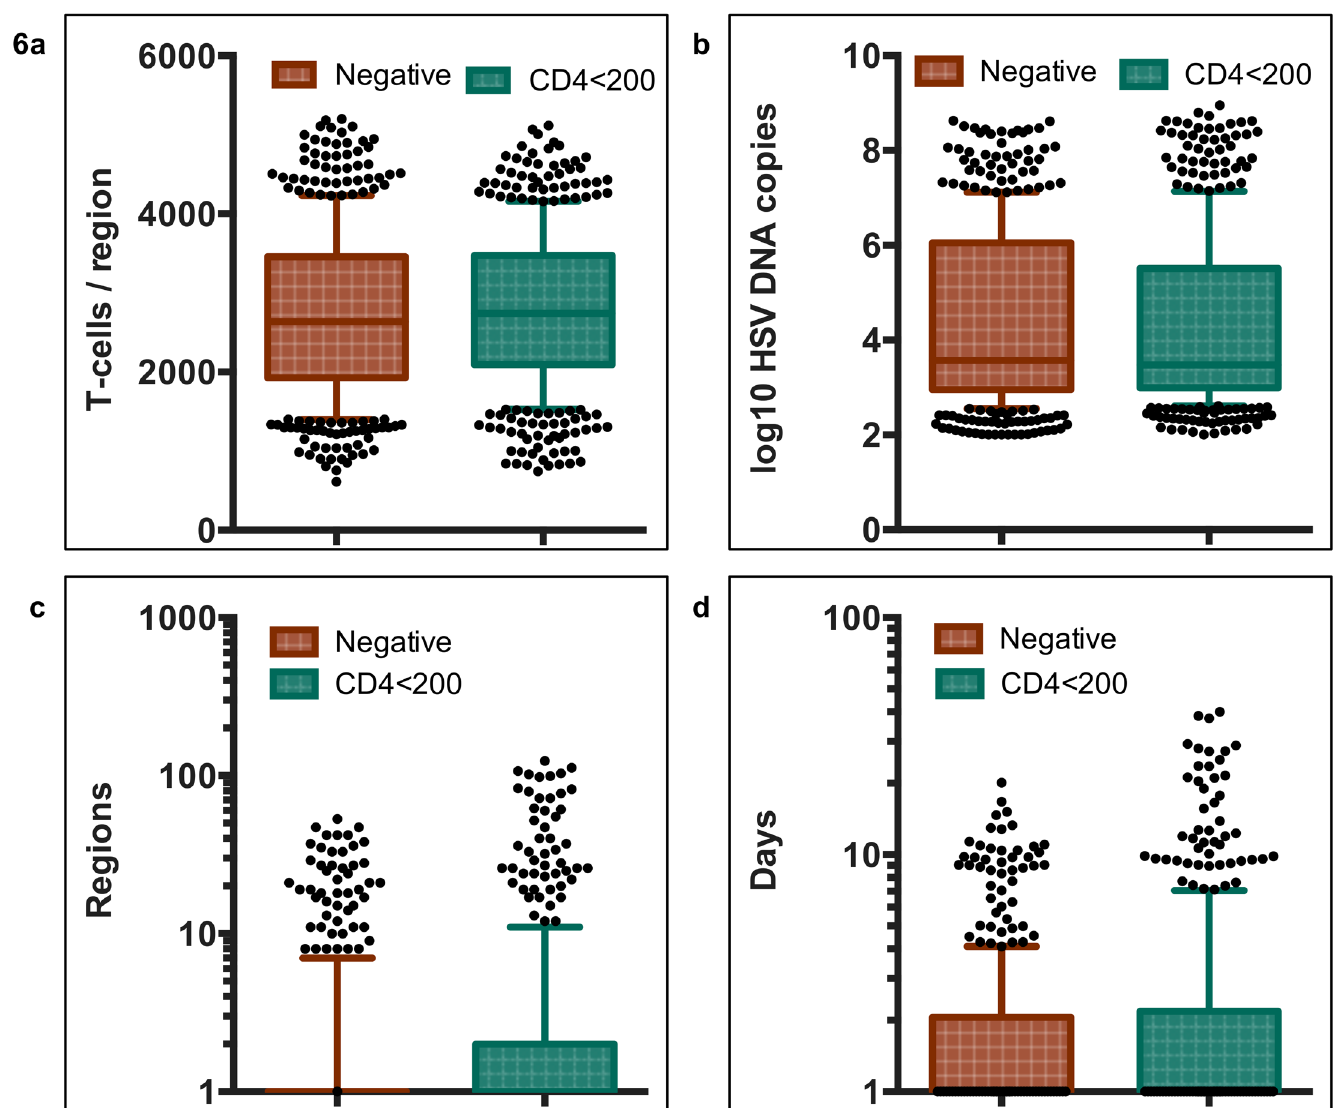
Fig 6. HSV-2 shedding episode characteristics in HIV-1 negative and positive men with CD4+ T-cells count < 200/ μ L. 500 simulated episodes with parameters optimized for HIV negative (orange) and HIV positive men with CD4+ T-cells < 200/ μ L (teal). Boxplots whiskers are inclusive of 90% of values and dots are simulations outside of this range. The box includes interquartile range and a median line. (A) Genital T-cell density in model region of episode initiation, (B) Peak HSV DNA copy number, (C) Number of infected regions per shedding episode, (D) Episode duration. Comparisons for each of the episode characteristics were not statistically significant with non-parametric Mann Whitney rank tests. However, simulations with CD4+ T-cells < 200/ μ L had higher proportions of episodes involving more than 50 regions (C) and lasting more than 10 and 20 days (D)